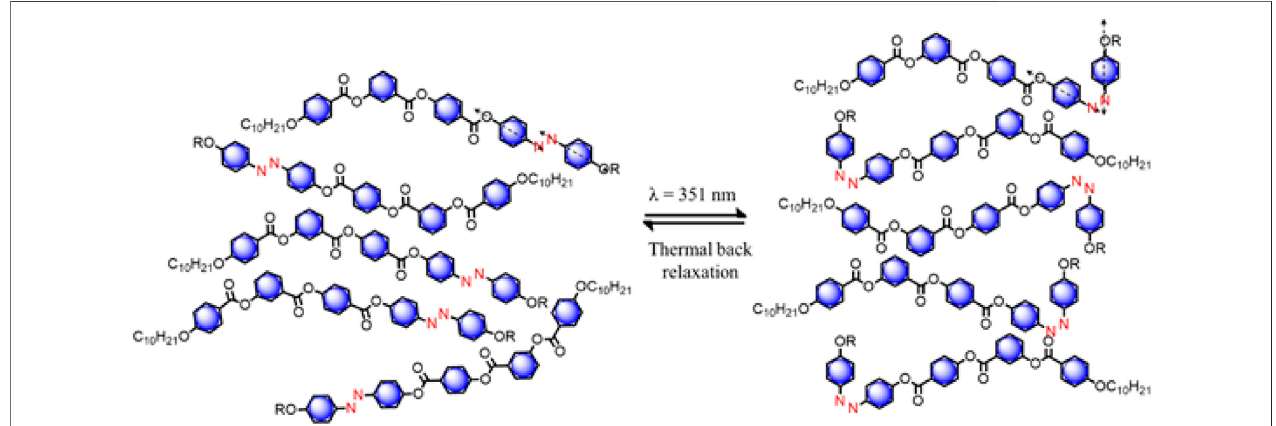
Frontiers in Physics |